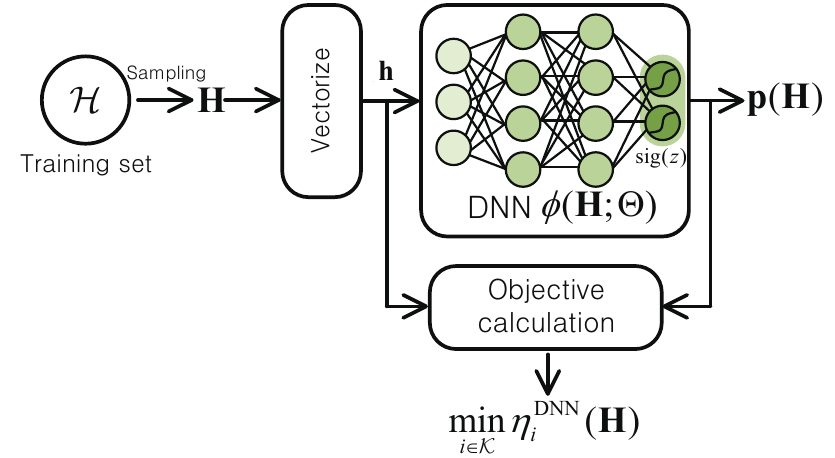
Figure 3. Proposed DNN-based EE fairness